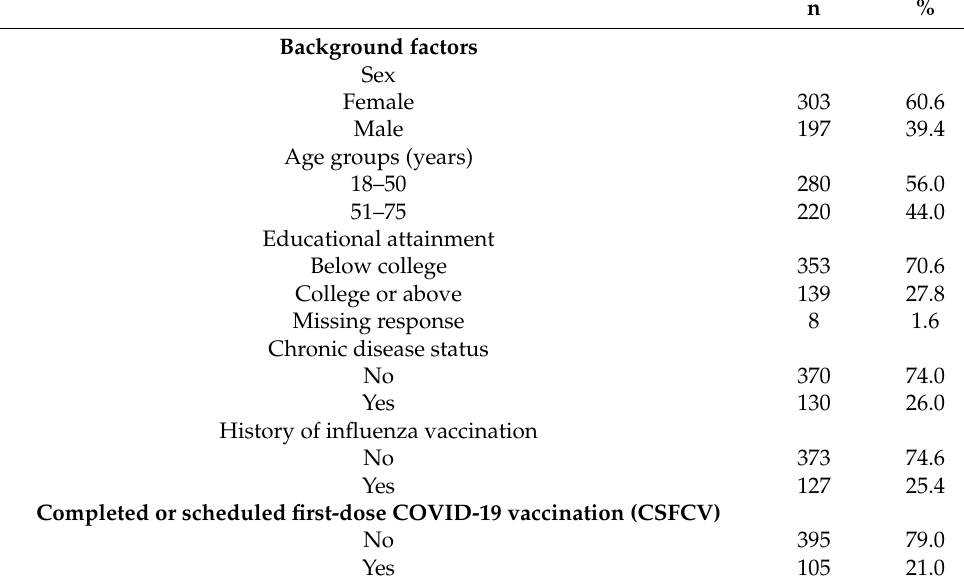
Table 1. Participants’ characteristics (n =